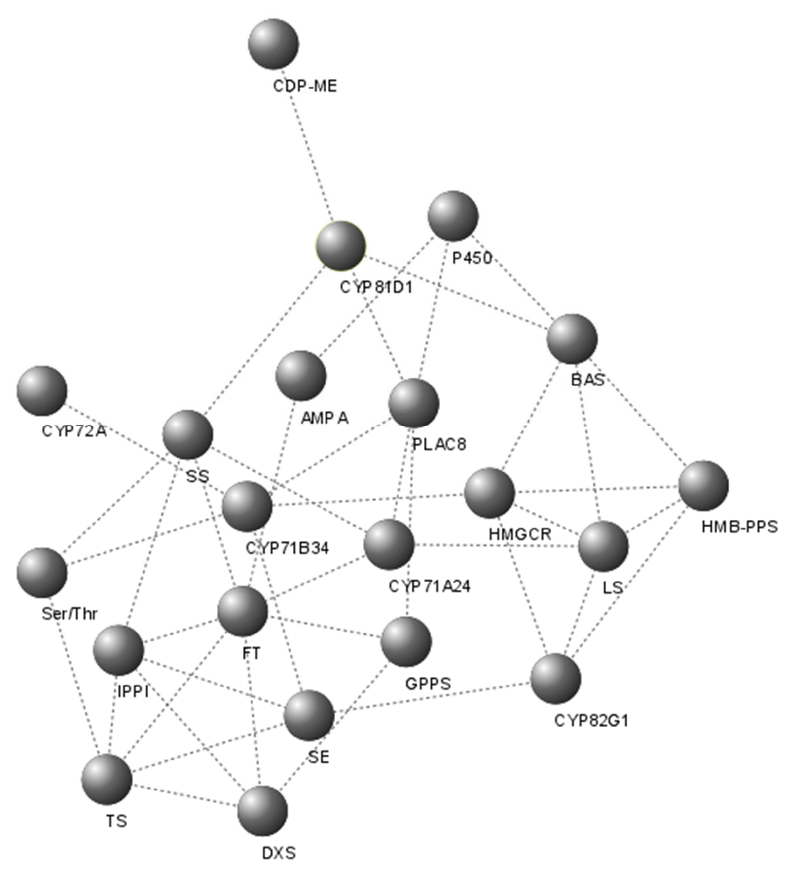
Figure 6. Co-expression network of transcripts related to the synthesis pathway of triterpenes and members of the cytochrome P450 family in leaves of the galphimine producer plants and non-galphimine producer plants. Transcripts are represented by spheres and dotted lines are their interaction. HMGCR (3-hydroxy-3-methylglutaryl-CoA reductase), DXS (1-deoxy-D-xylulose-5-phosphate synthase), CDP-ME (4-diphosphocytidyl-2-C-methyl-D-erythritol kinase), HMB-PPS (4-hydroxy-3-methylbut-2-en-1-yl diphosphate synthase), IPP isomerase (isopentenyl diphosphate isomerase), GPPS (geranyl diphosphate synthase), FT (farnesyl transferase), TS (terpene synthase), SS (squalene synthase), SE (squalene epoxidase), BAS (beta-amyrin synthase), LS (lanosterol